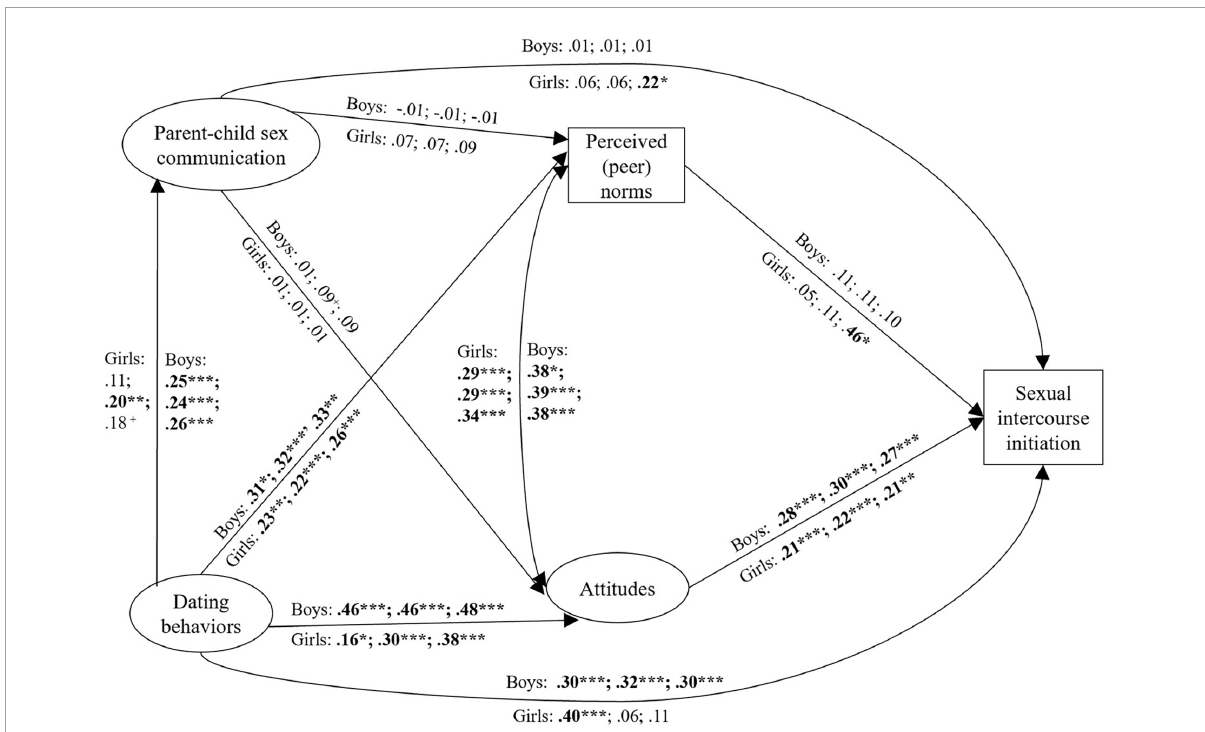
FIGURE2 Standardized path coefficients (standard errors) arc presented for the partially constrained structural model across generational status groups (standardized results). Path coefficients for 1st-, 2nd-, and 3rd- generation status groups are presented in that order. Path coefficients above or to the right of paths represent results for Latino boys. Path coefficients below or to the left of paths represent results for Latina girls. Age at grade, household income, and parental household composition were controlled for on the exogenous and outcome variables. Factor loadings and residuals of the measurement model are provided in Table 3 . Bold indicates significant coefficients. *p < 0. 05, **p < 0. 01, *** p <